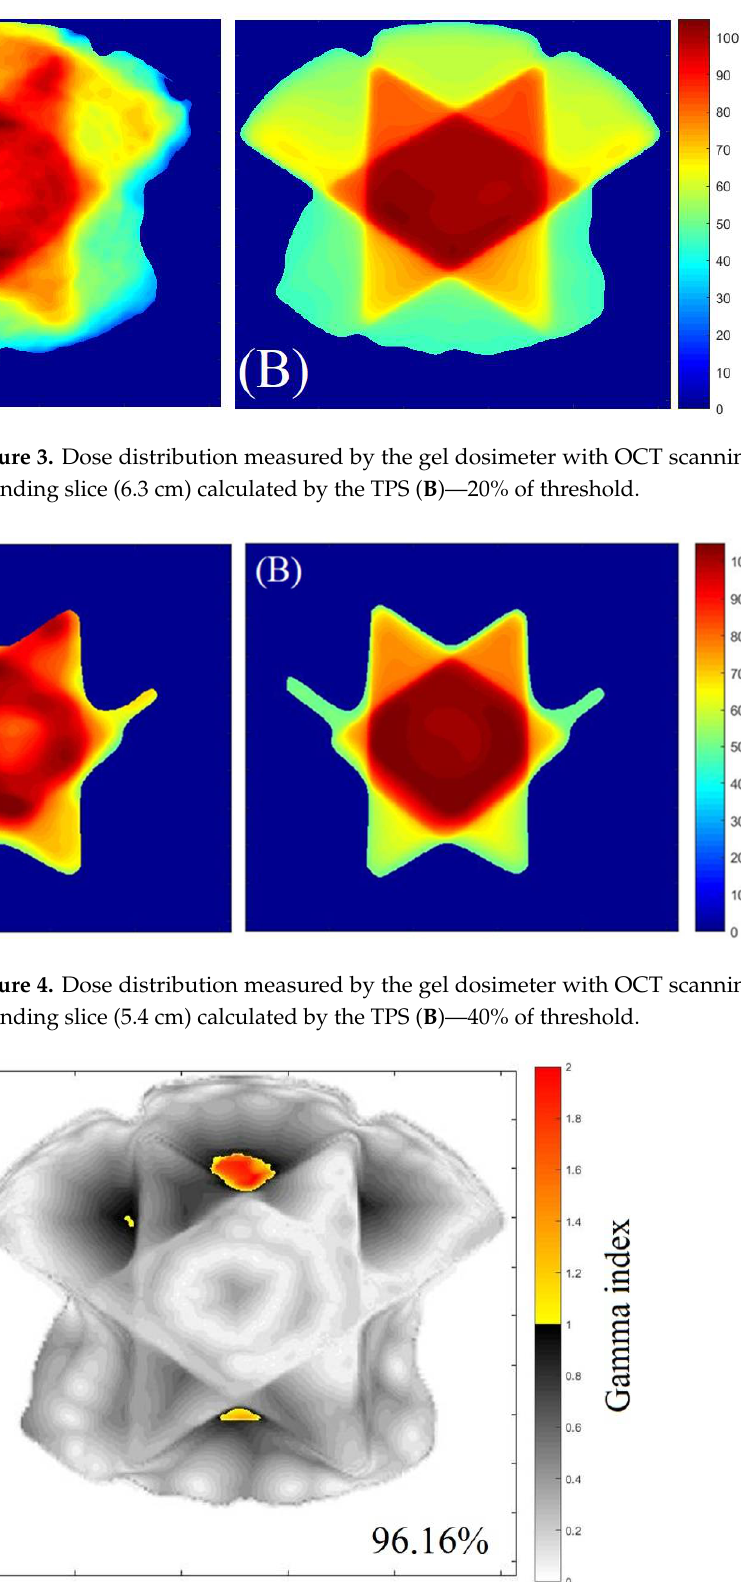
Figure 6. Gamma map index comparing the measured image and calculated image of Figure 9, with 99.82% of approved pixels (z = 5.4cm) 40% of threshold. Table 1 shows the percentage of approved points in the gamma analyses at all slices evaluated at the junction region for both thresholds employed. The average approved pixels’ percentage in this measurement is 94.09% (86.24–96.16%) with 20% of the dose threshold and 94.05% (94.5–99.9%) with 40% of the dose threshold. These measurements are approved considering the established criteria. The 3DD approval importance is noteworthy because all the dose points in the matching field region were evaluated, which is different than in any other dosimetric technique. However, regions with less than 90% of approved pixels were found and called to attention; these include z coordinates between 7.8, 7.9, and 8.0 cm for the 20% threshold analysis and between 7.9 and 8.0 cm for the 40% threshold analysis. If we look at the sagittal and coronal views of the gamma analysis results, we can see the region where these fails are concentrated (Figures 7 and 8 for the 20 and 40% of dose threshold, respectively). For both dose thresholds, the fails are almost in the same place with slight differences in size. In this case, even with the plan approval, the concentration of the fails